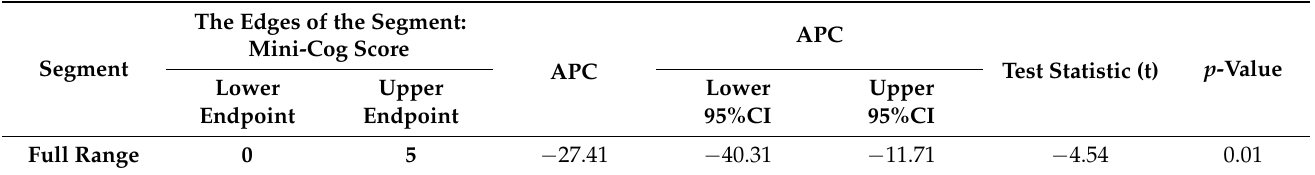
Table 4. Predicted probability of postoperative delirium according to Mini-Cog score (based on Joinpoint regression model).